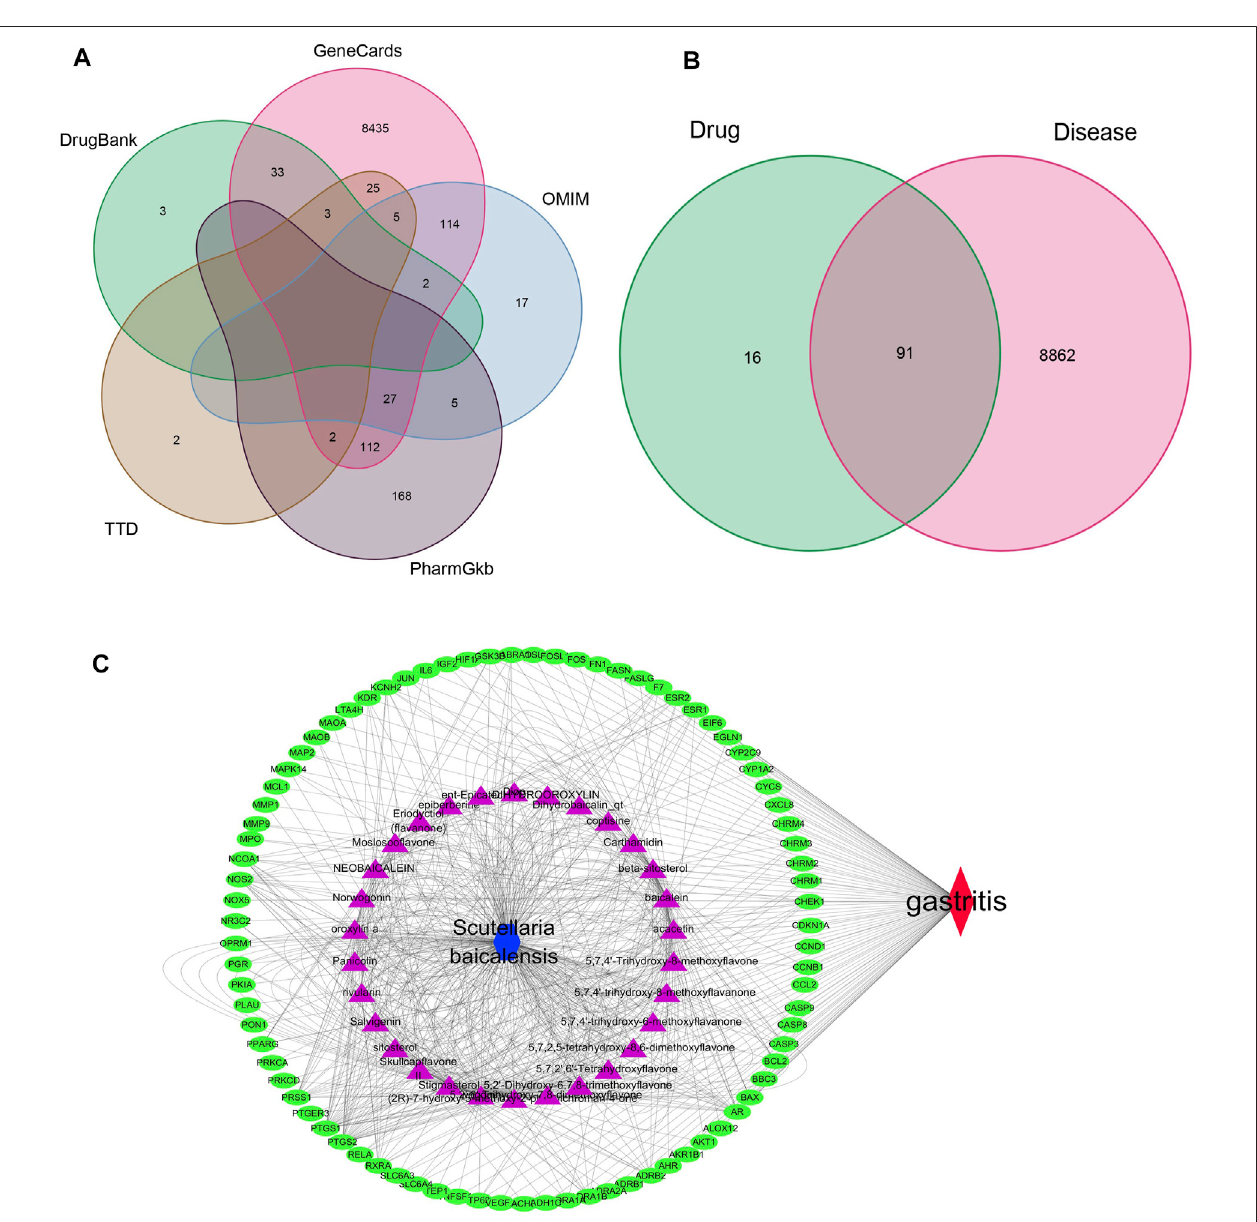
FIGURE1|(A) TheVenndiagramoftheintersectionofgastriccancer-relatedgenesobtainedfrom fi vedatabases. (B) Venndiagramoftheintersectionoftargetgenes of Scutellaria baicalensis Georgi and gastric cancer-related genes. (C) The network map of “ Scutellaria baicalensis Georgi-compound-drug action target-disease. ”